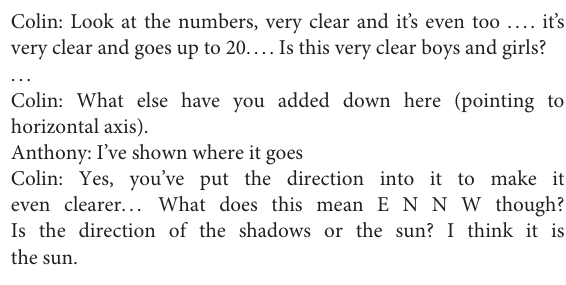
board—recapitulating the transduction process. Figure